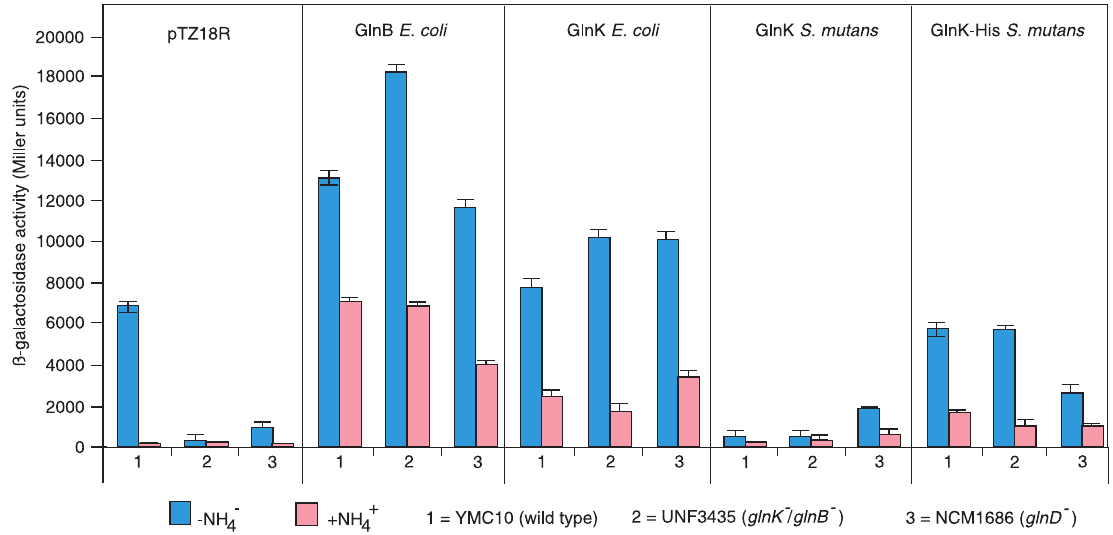
Figure 4. Effect of Streptococcus mutans GlnK protein on Klebsiella pneumoniae NifA activity. All Escherichia coli strains carry a ( nifH::lacZ ) fusion and plasmid pCC46, which contains the nifLA operon of K. pneumoniae . Strains were grown in the absence or pres- ence of ammonium chloride (20 mM), under anaerobic conditions. β-galactosidase activity is reported in Miller units. Results are the means of at least three experiments with standard deviations of